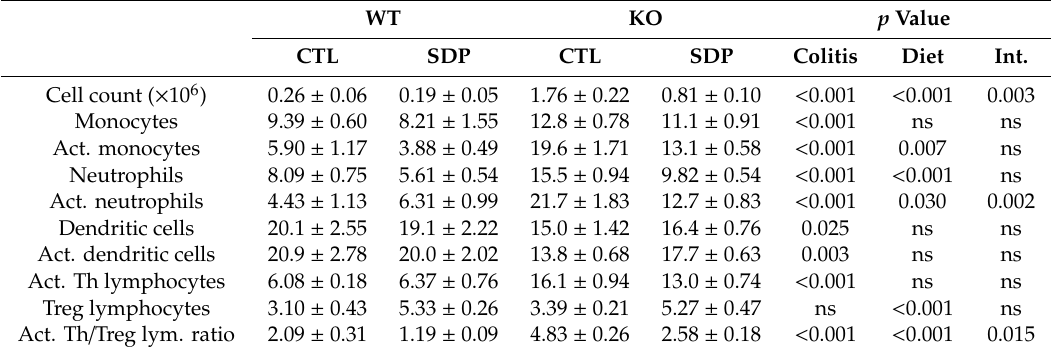
Table 3. E ff ects of SDP Supplementation on The Immune Population of The Intraepithelial Compartment In The Colonic Mucosa of Mdr1a KO mice.